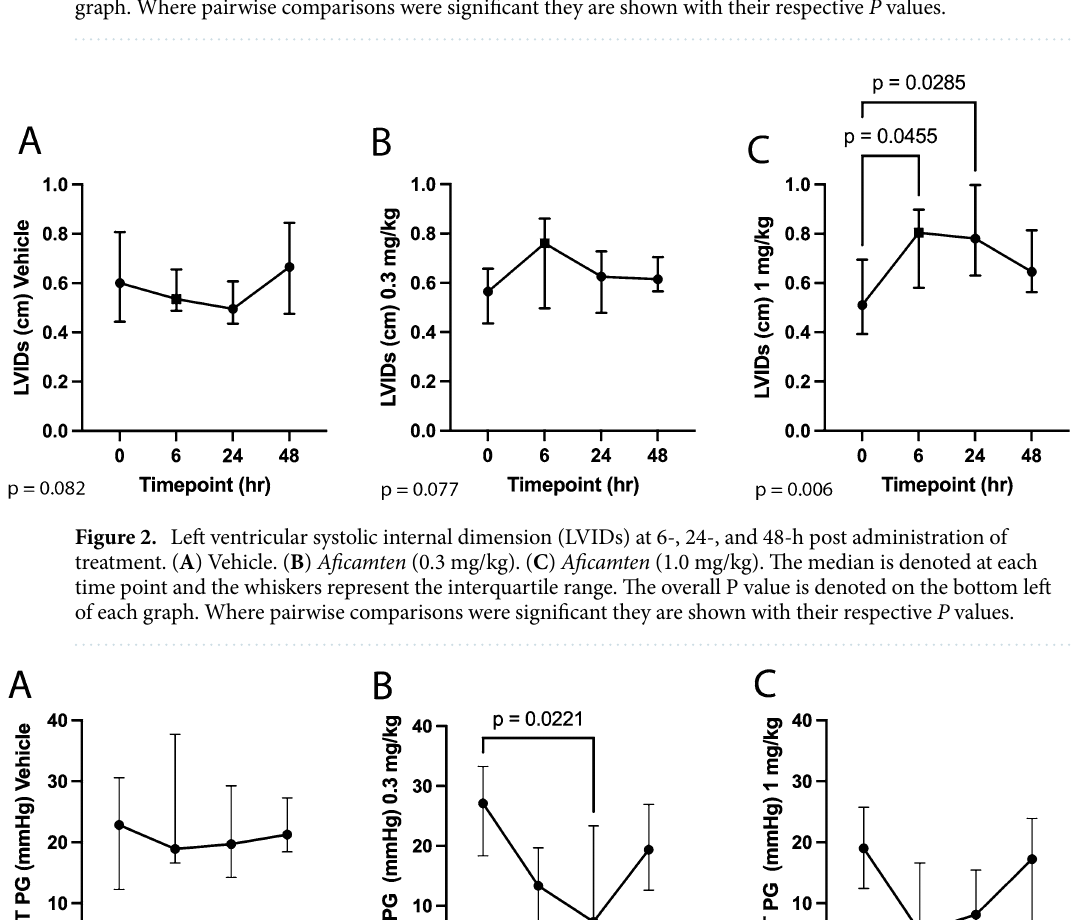
Figure 1. Left ventricular fractional shortening (LV FS) at 6-, 24-, and 48-h post administration of treatment. ( A ) Vehicle. ( B ) Aficamten (0.3 mg/kg). ( C ) Aficamten (1.0 mg/kg). The median is denoted at each time point and the whiskers represent the interquartile range The overall P value is denoted on the bottom left of each graph. Where pairwise comparisons were significant they are shown with their respective P values.